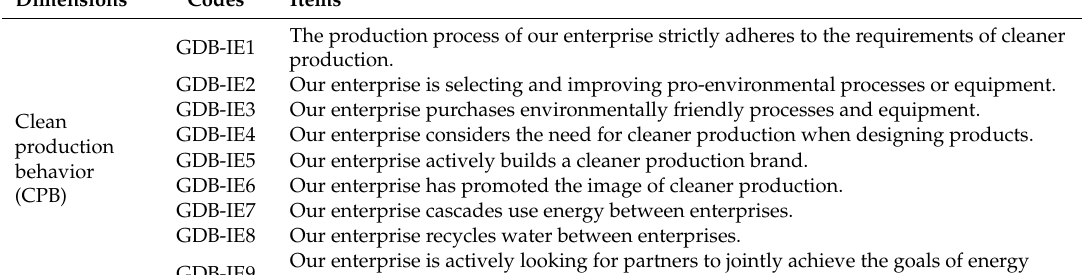
Table A3. Questionnaire items on the green development behavior of industrial enterprises (GDB-IE) [22].